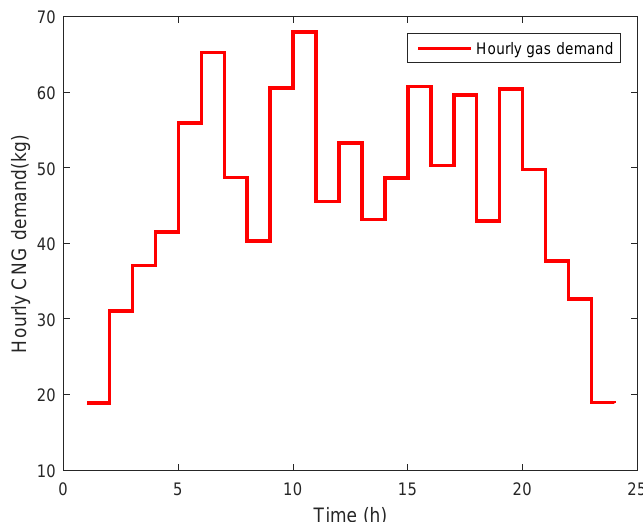
Figure 3. Average hourly gas demand profile for the Johannesburg CNG fuelling station.